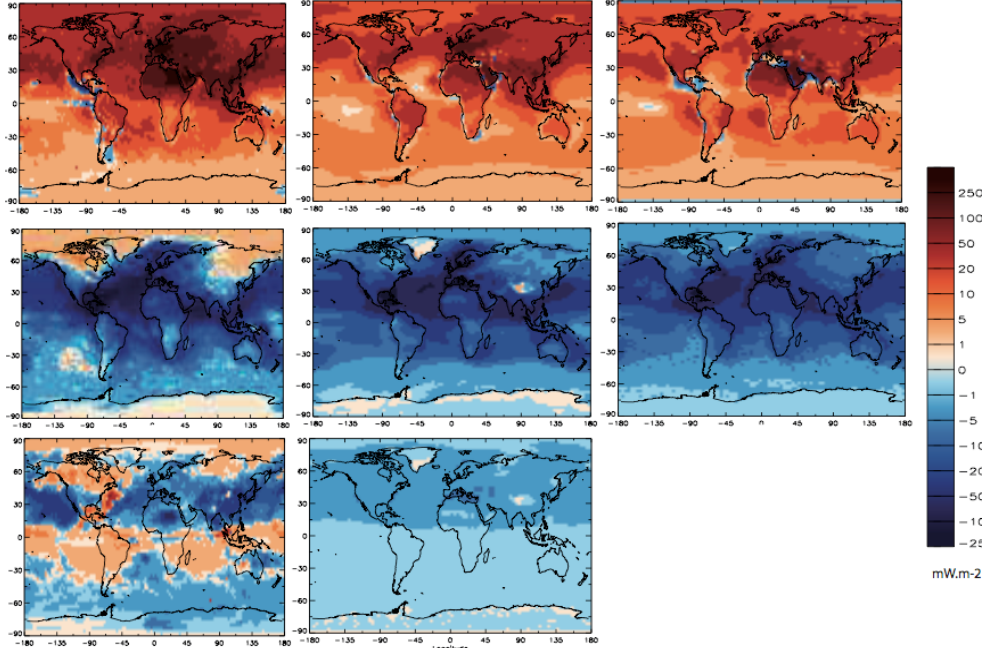
Figure 2. Fig. 2. All-sky radiative forcings (mWm − 2 ) of the direct aerosol effect from the three models: UiO (left column), LSCE (middle column) and UREAD (right column). The first line represents the RF from road activities, the second line, RF from shipping and the third line RF from aviation. Radiative forcings from LSCE and UREAD radiation codes are shown for BC externally mixed with the other aerosol component, whereas for UiO, radiative forcings are computed for BC internally mixed with other aerosol types.